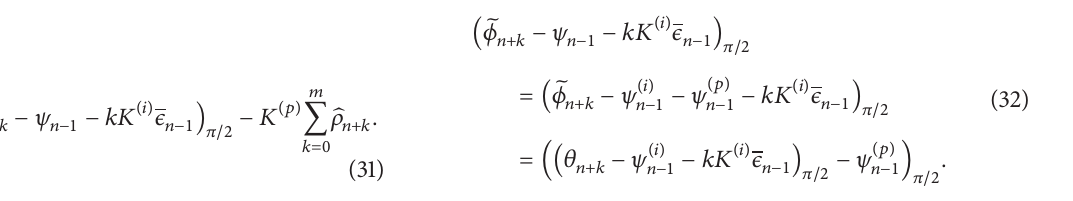
4.2. Proportional Loop. From (29), it is simple to show that From (12) and (17), note